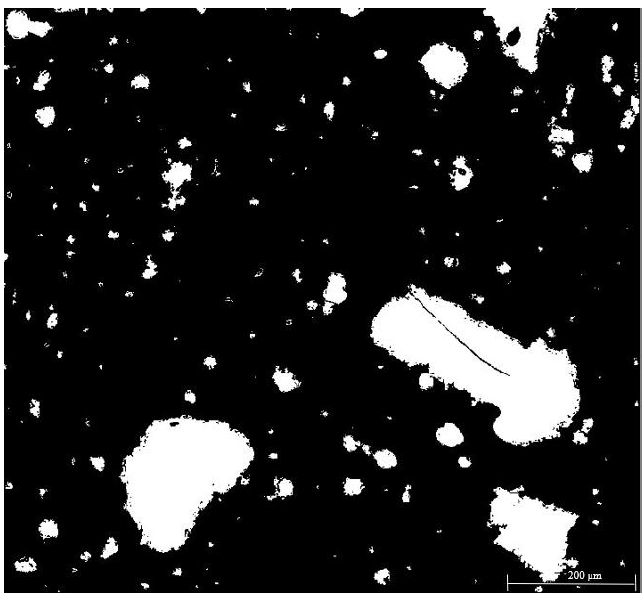
Figure 11. SEM backscatter image converted to binary to calculate an averaged surface area of TiO